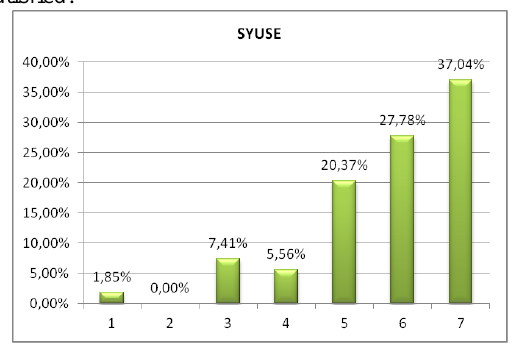
Figure 8. The reproduction of Van Gog’s Self-portrait as recorded by the